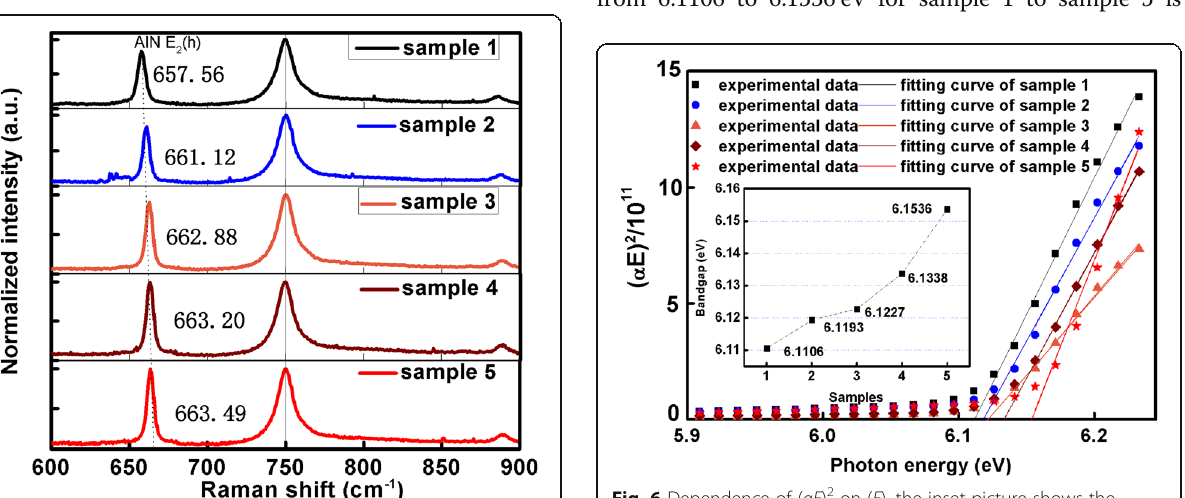
Fig. 6 Dependence of ( α E ) 2 on ( E ), the inset picture shows the bandgap of AlN